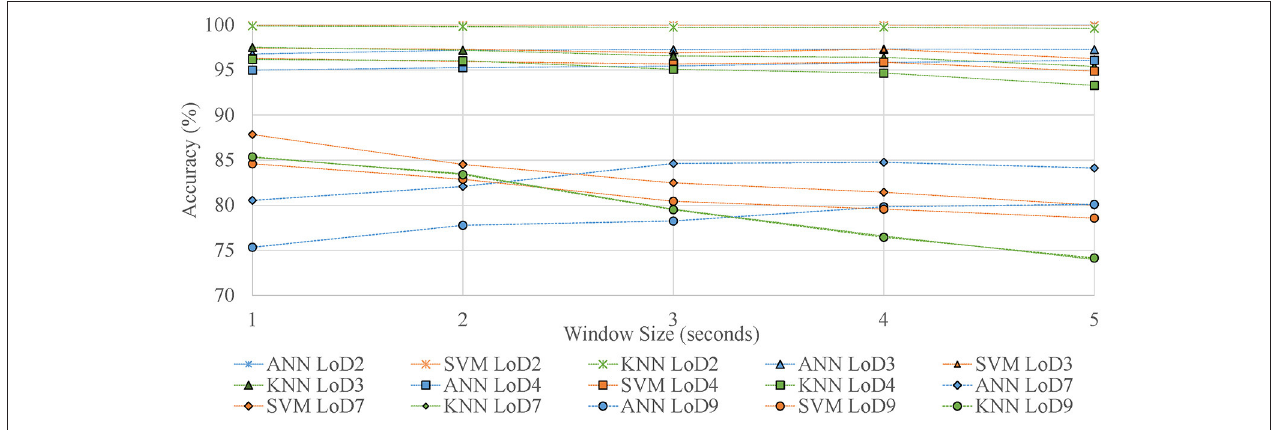
FIGURE 8 | Accuracy of classifiers with different window sizes.